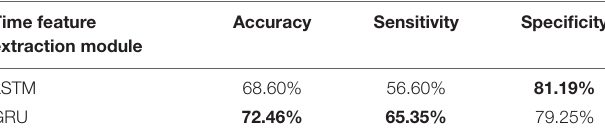
The bold values in this table represent the optimal values of accuracy, specificity and sensitivity. TABLE 5 | Classification performance of different time interceptions.